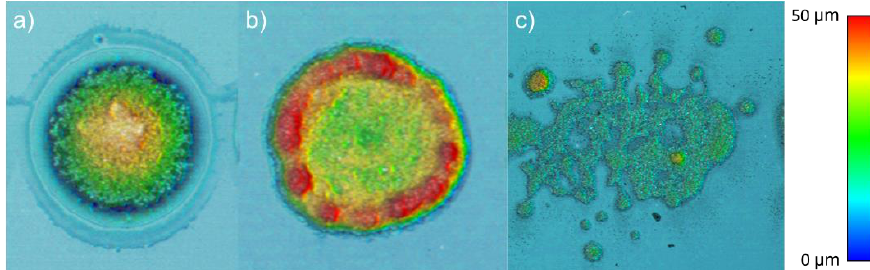
Figure 10. Dot transferred with energy values just over the threshold ( a ), crowned structure after breaking a stable column established between both substrates ( b ), and paste spray onto the acceptor substrate ( c ), and from PV19B 5 wt. % organic solvent added paste.